Question: What kind of plot is shown here?
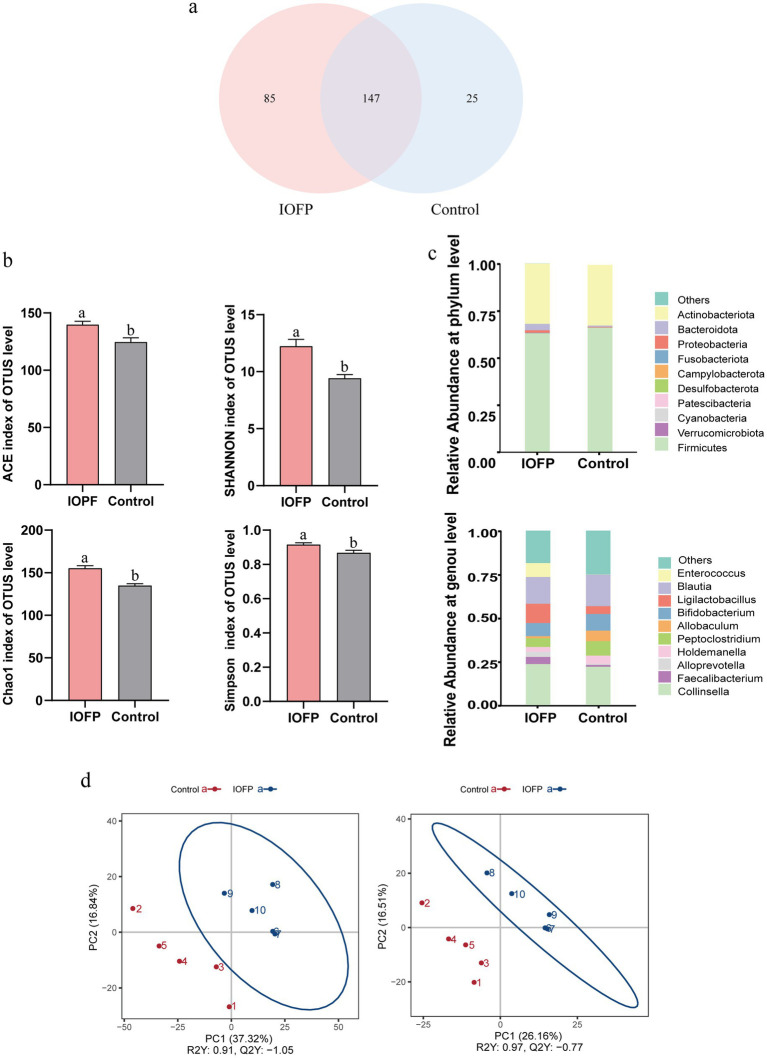
Answer: bar